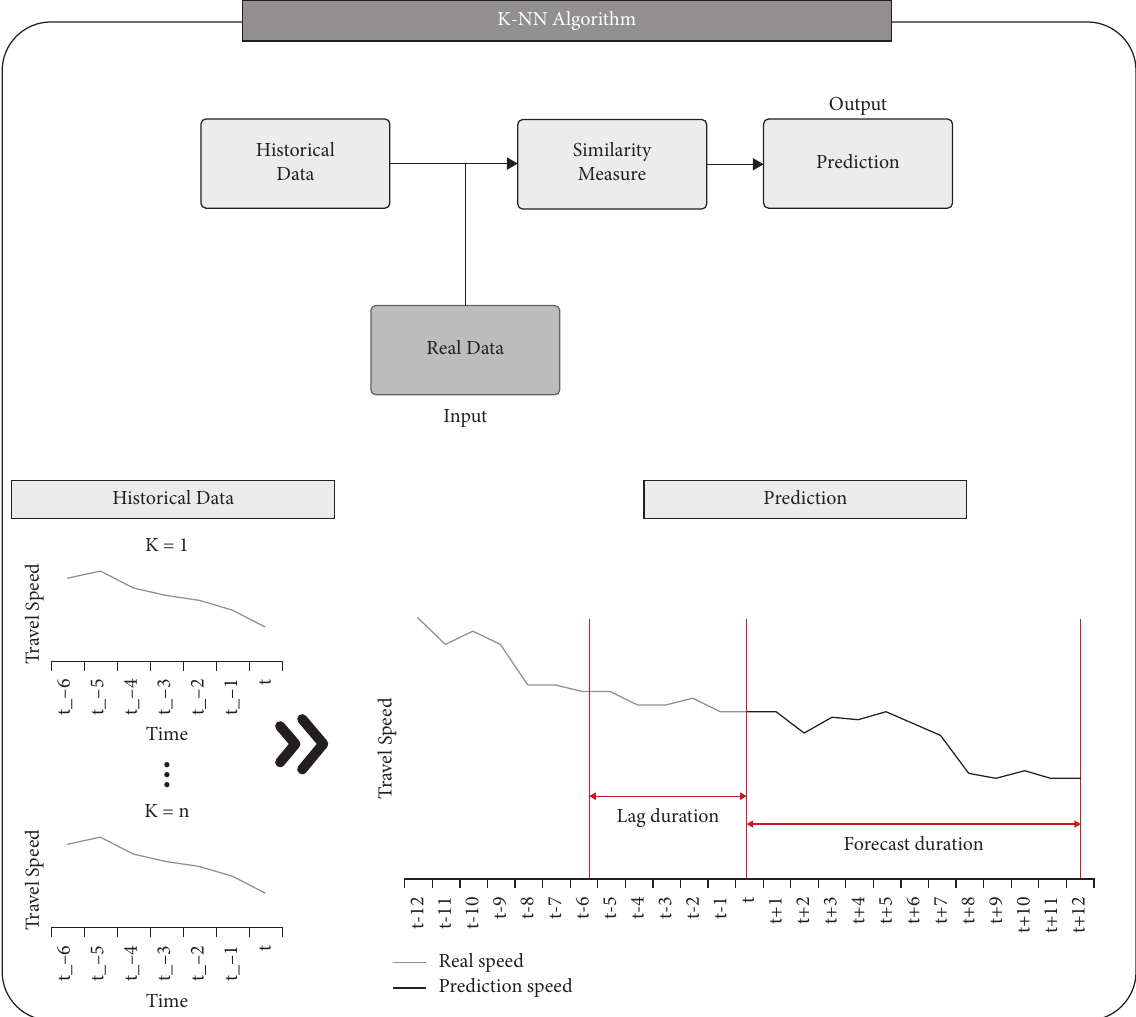
Figure 3: Framework of clustered K-nearest neighbors (CKNN)